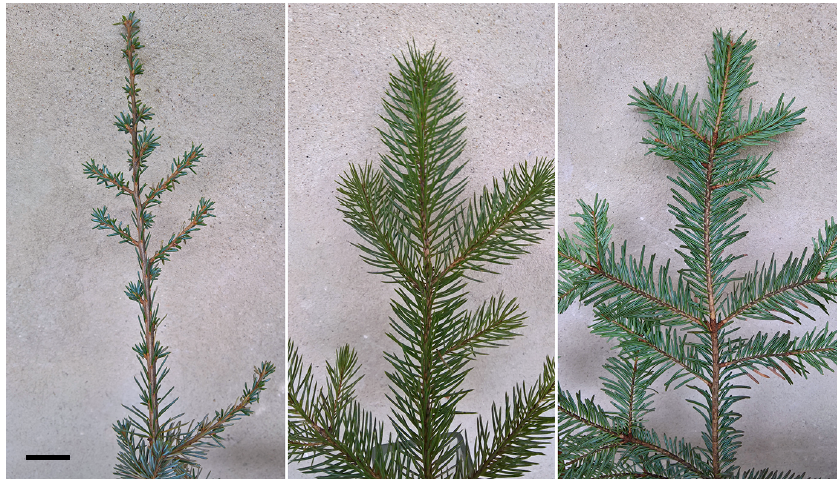
Figure 2 Branching shoots of investigated coniferous species. Left photograph – Cedrus libani subsp. atlantica , middle – Picea abies , right – Abies alba . Scale bar: 30 mm, is the same for all photographs.